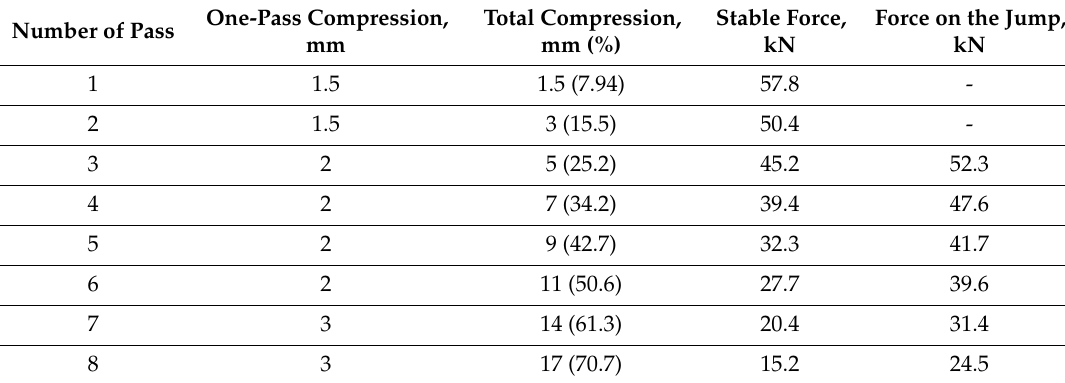
Table 2. Rolling forces per passes.